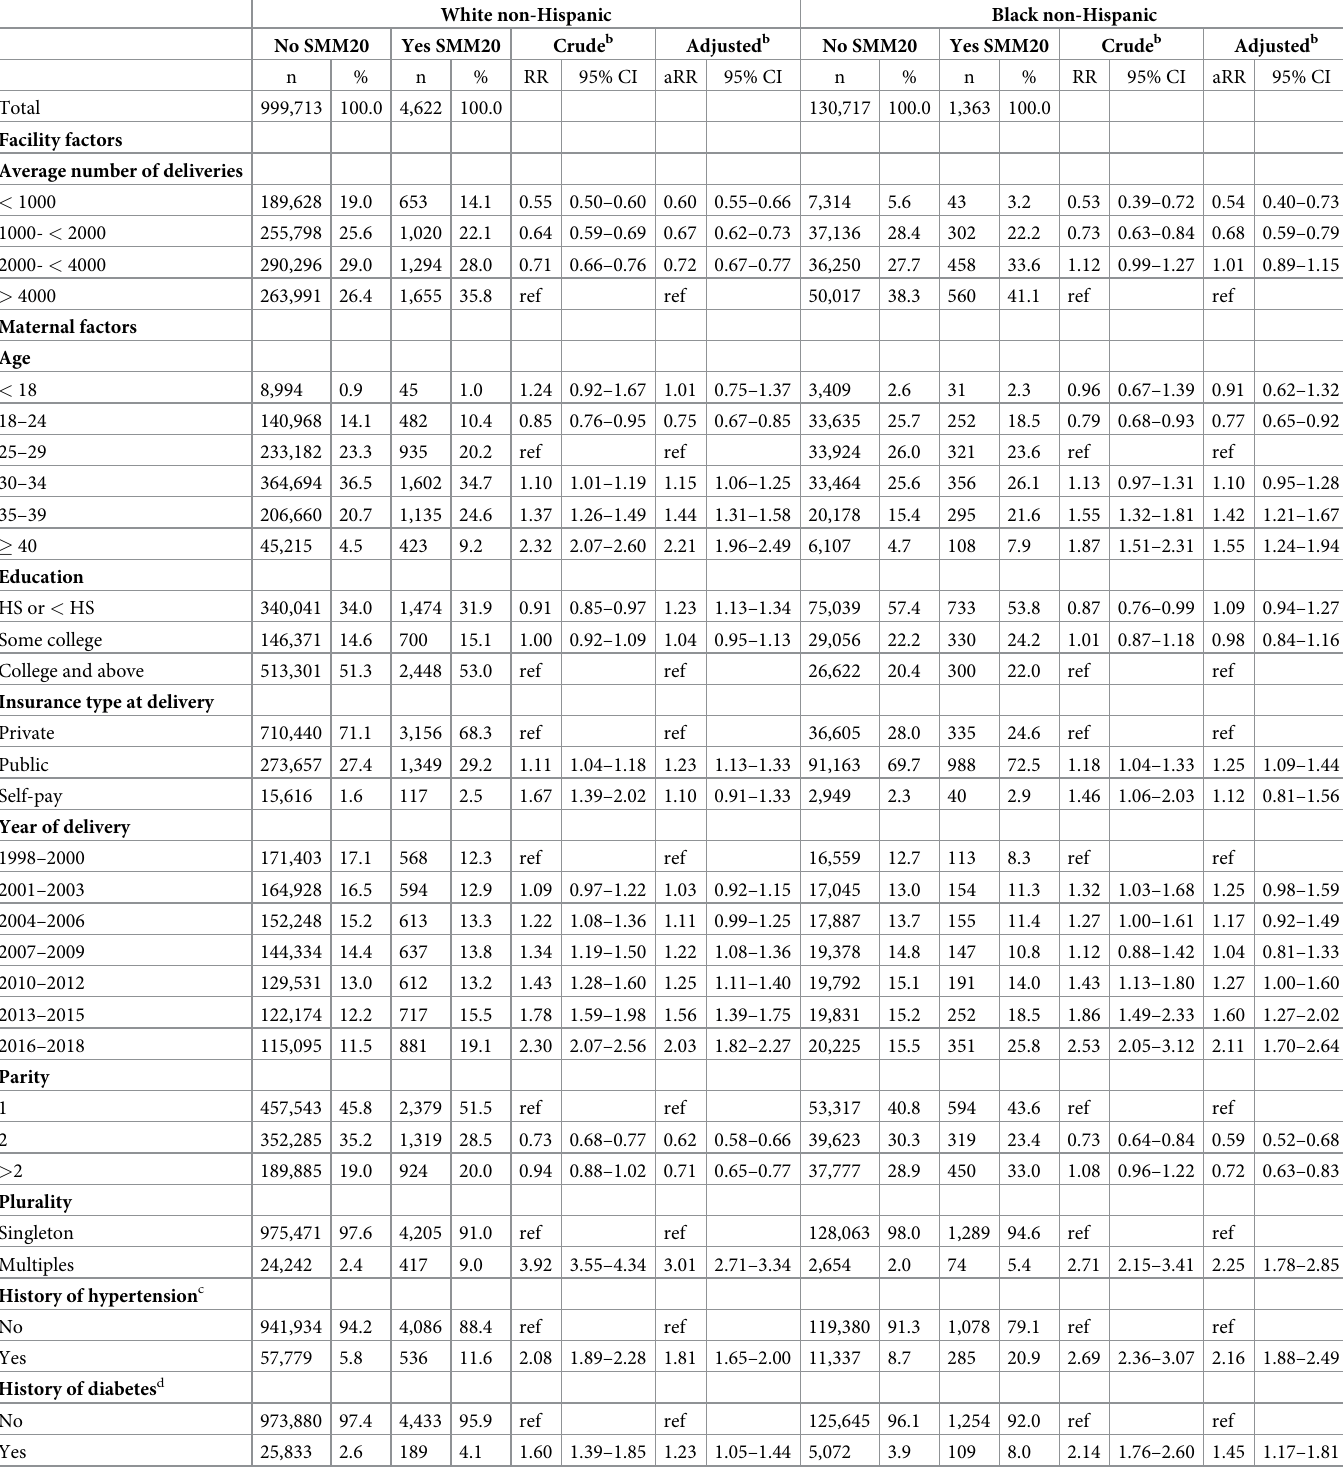
Table 2. Characteristics associated with severe maternal morbidity a for White non-Hispanic and Black non-Hispanic birthing people: Massachusetts, January 1, 1998-December 31,